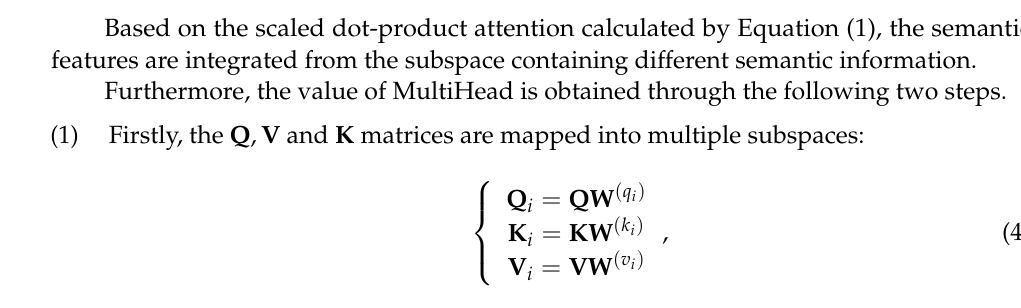
features are integrated from the subspace containing different semantic